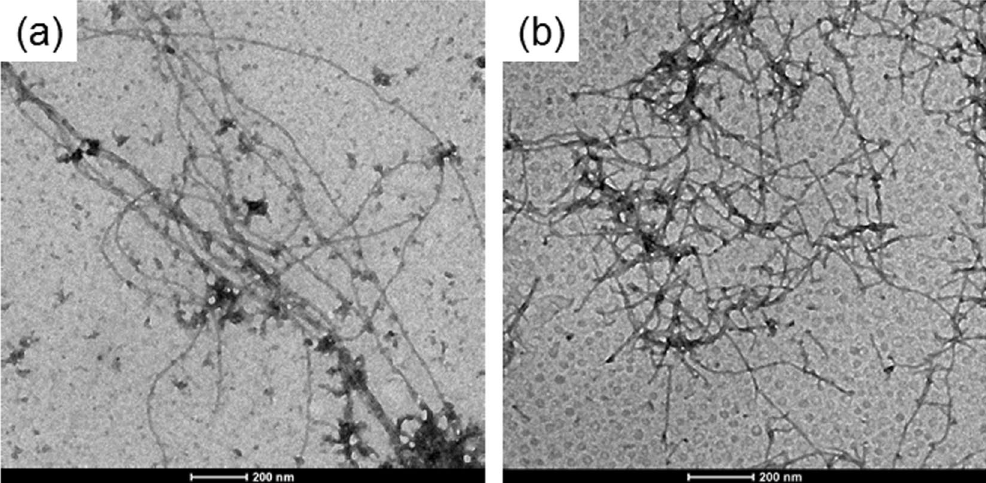
Figure 4. Selected TEM images for 2Nal 2 ( a ) and Gd-2Nal 2 ( b ) at 5.0